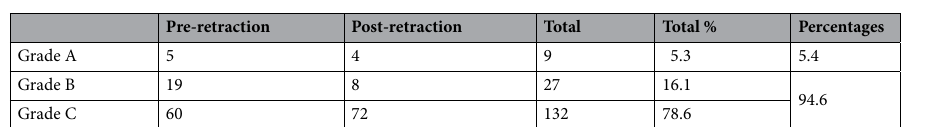
Table 3. Shows the total number of the canine root/cortical bone grades in the pre- and post-retraction CBCT’s.